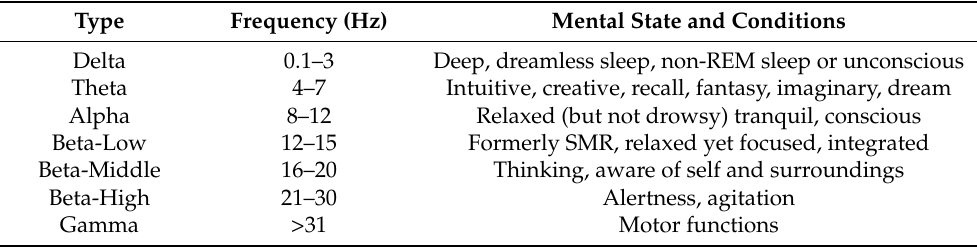
Table 3. EEG frequency bands and conditions.